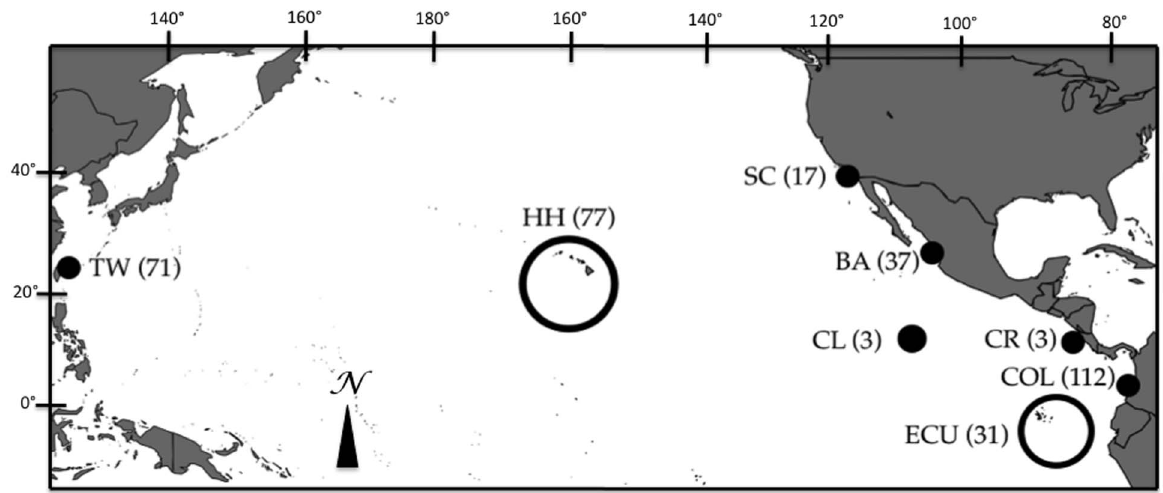
Figure 1. Map indicating sampling locations in the Pacific Ocean. TW=Taiwan, HH=Hawaii, BA=Baja, SC=Southern California, CL=Clipperton Island, CR=Costa Rica, COL=Colombia, ECU=Ecuador. Sample numbers for each location are shown in parentheses.